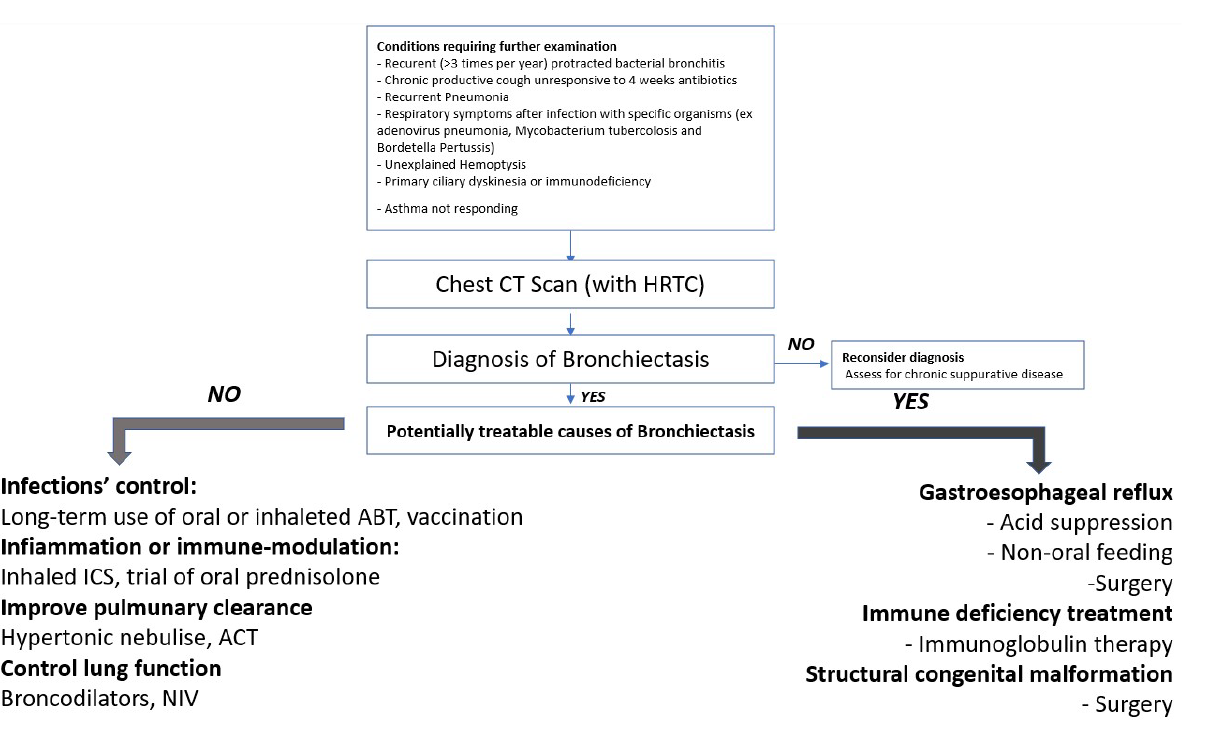
Figure 1. Management of NCFB.